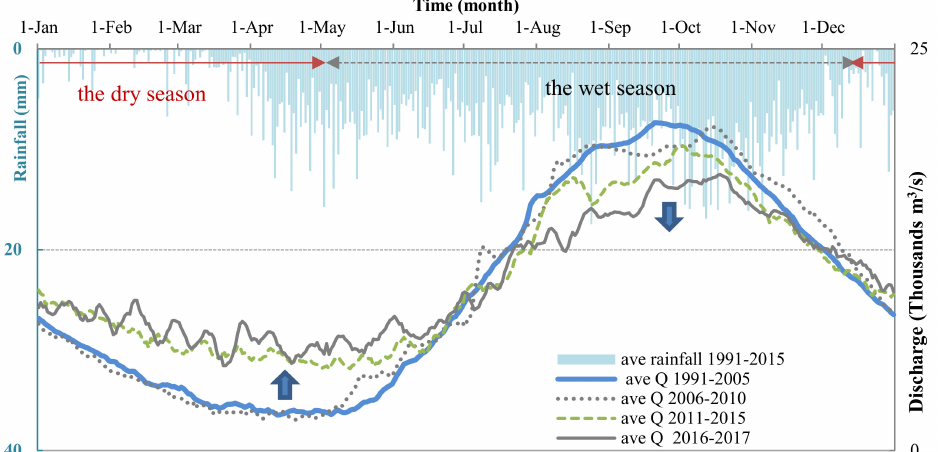
Figure 1. Average hourly discharge (Q) from 2006 to 2017 and average daily rainfall from 1991 to 2015 at Tan Chau Station in An Giang. The discharge imposes a decreasing trend in the wet season and an increasing trend in the dry season. All data were collected from the Southern Regional Hydro-meteorological Center (SRHMC) in Vietnam [33].